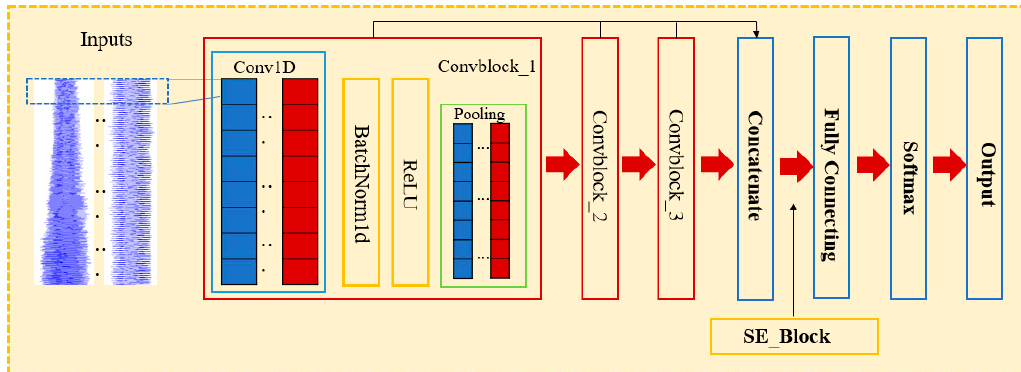
Figure 4. SE-MCNN Model structure